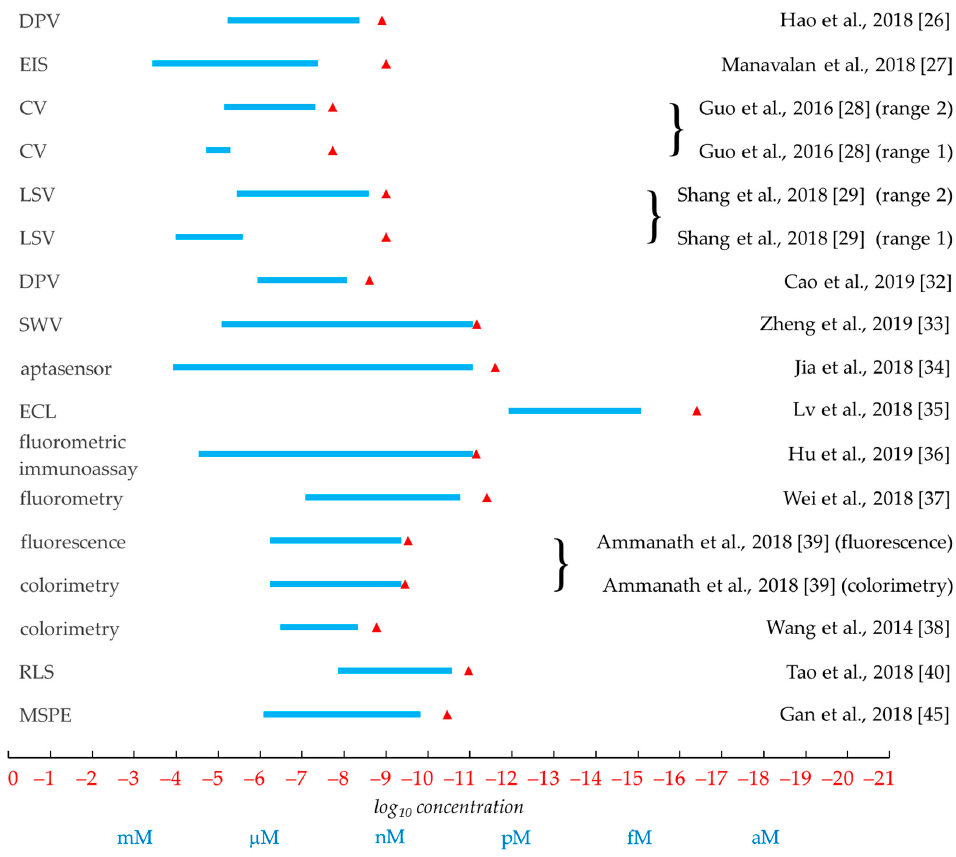
Figure 14. Measurement ranges ( blue bars ) and LOD values ( red triangles ) of quantitative analytical methods. The quantitation methods are listed on the left, the references on the right side.